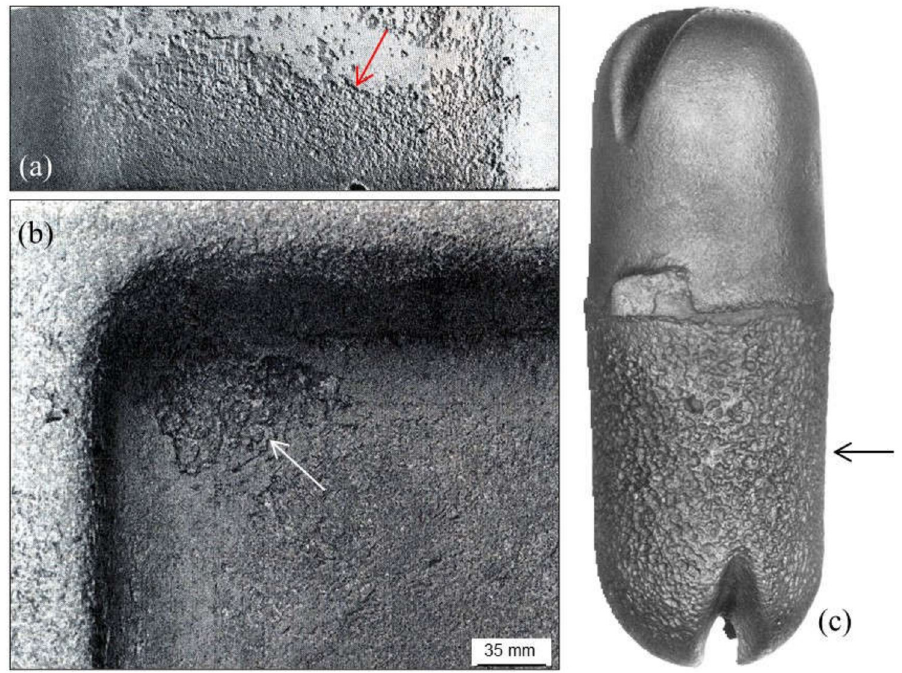
Figure 50. ( a ) Pitting or orange peel defect in heavy-section ductile iron bar with 3.5 wt.% Si; ( b ) defect located in an internal corner (hot spot) and ( c ) variant with vitrified aspect found in a test grey iron casting with cumulative contamination of core waste products and insufficient regeneration in the low half (Reprinted with permission from ref. [17]. Copyright 1999 American Foundry Society, page